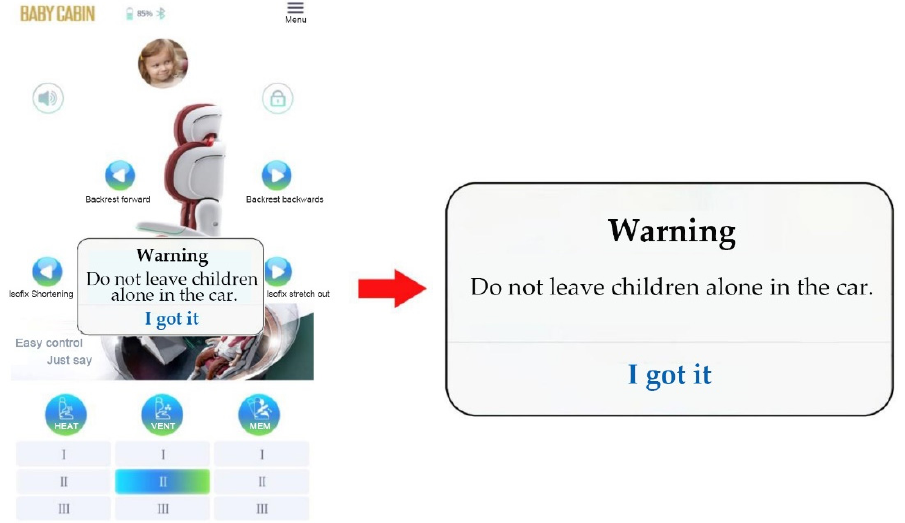
Figure 6. Out-of-seat safety alert.